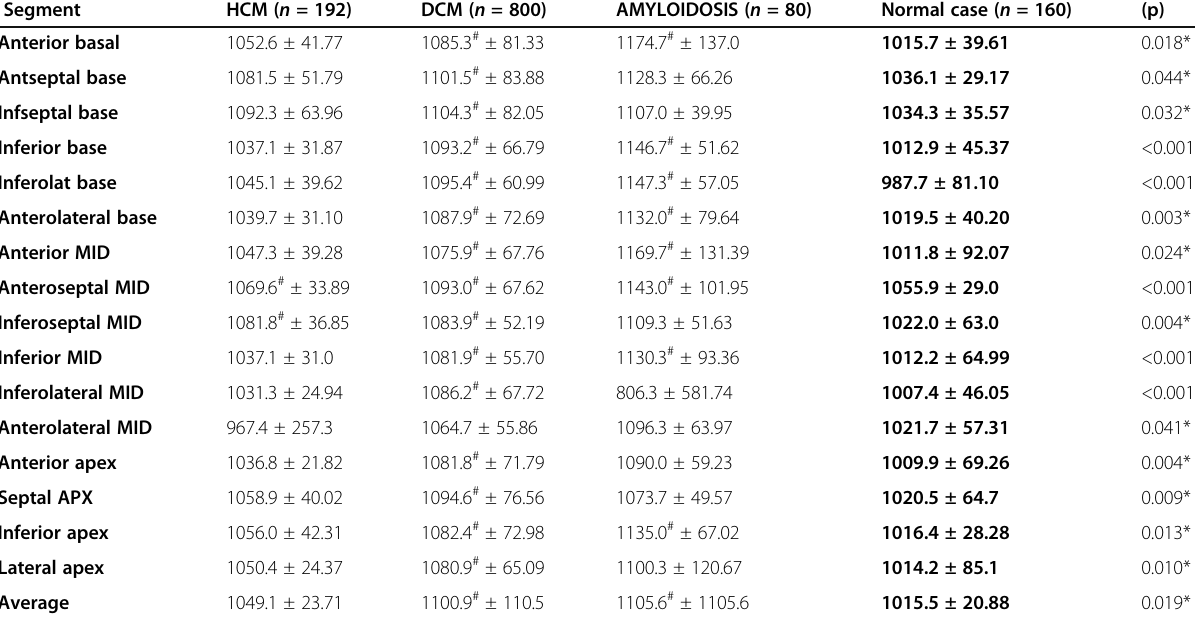
Table 2 Comparison between the different studied groups to control group according to native T1 values